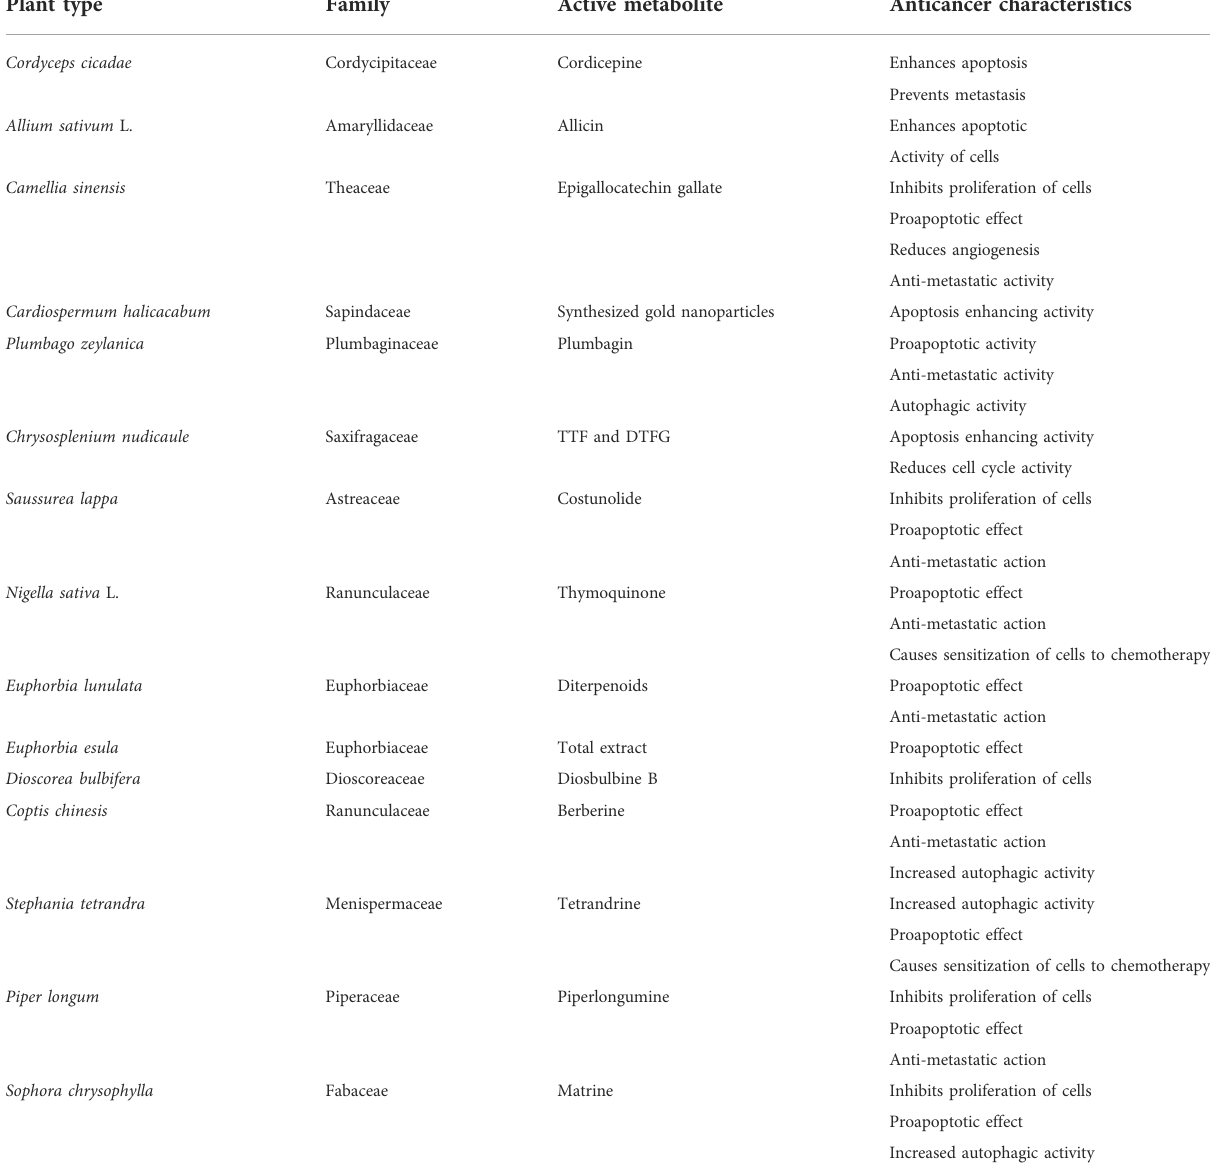
TABLE 3 A number of phytochemicals with their active compounds and anticancer characteristics (Nakonieczna et al.,